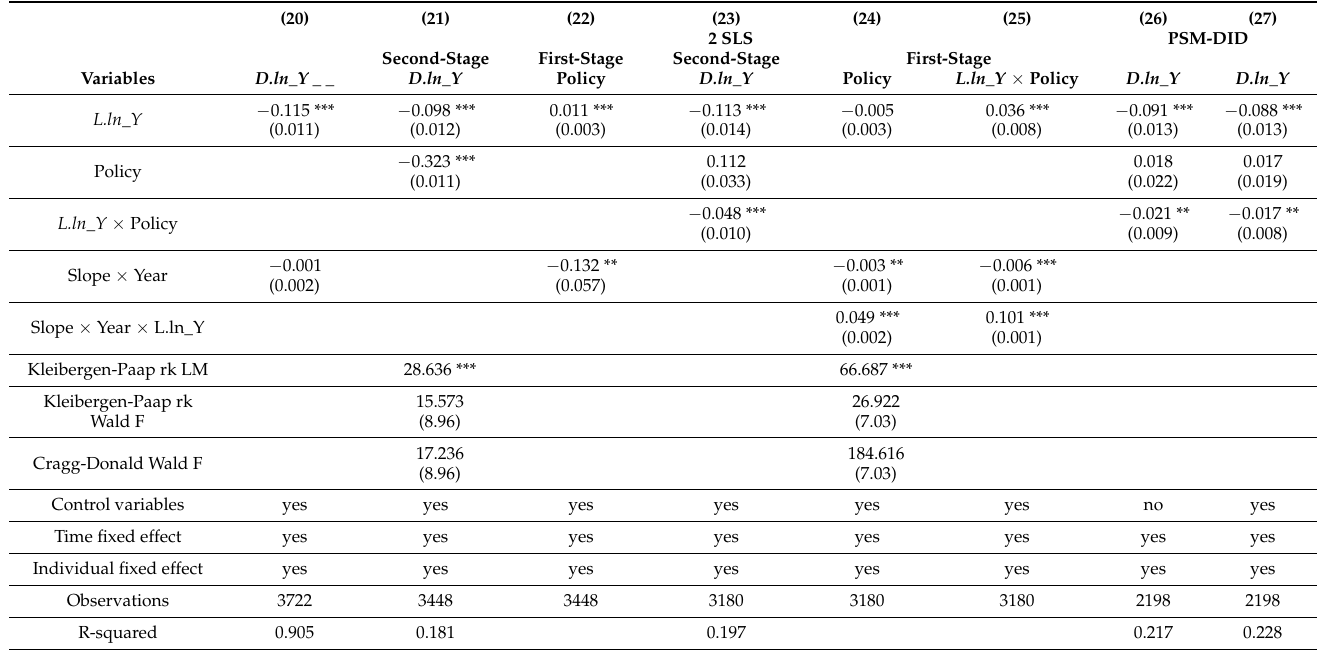
Table 5. Endogeneity